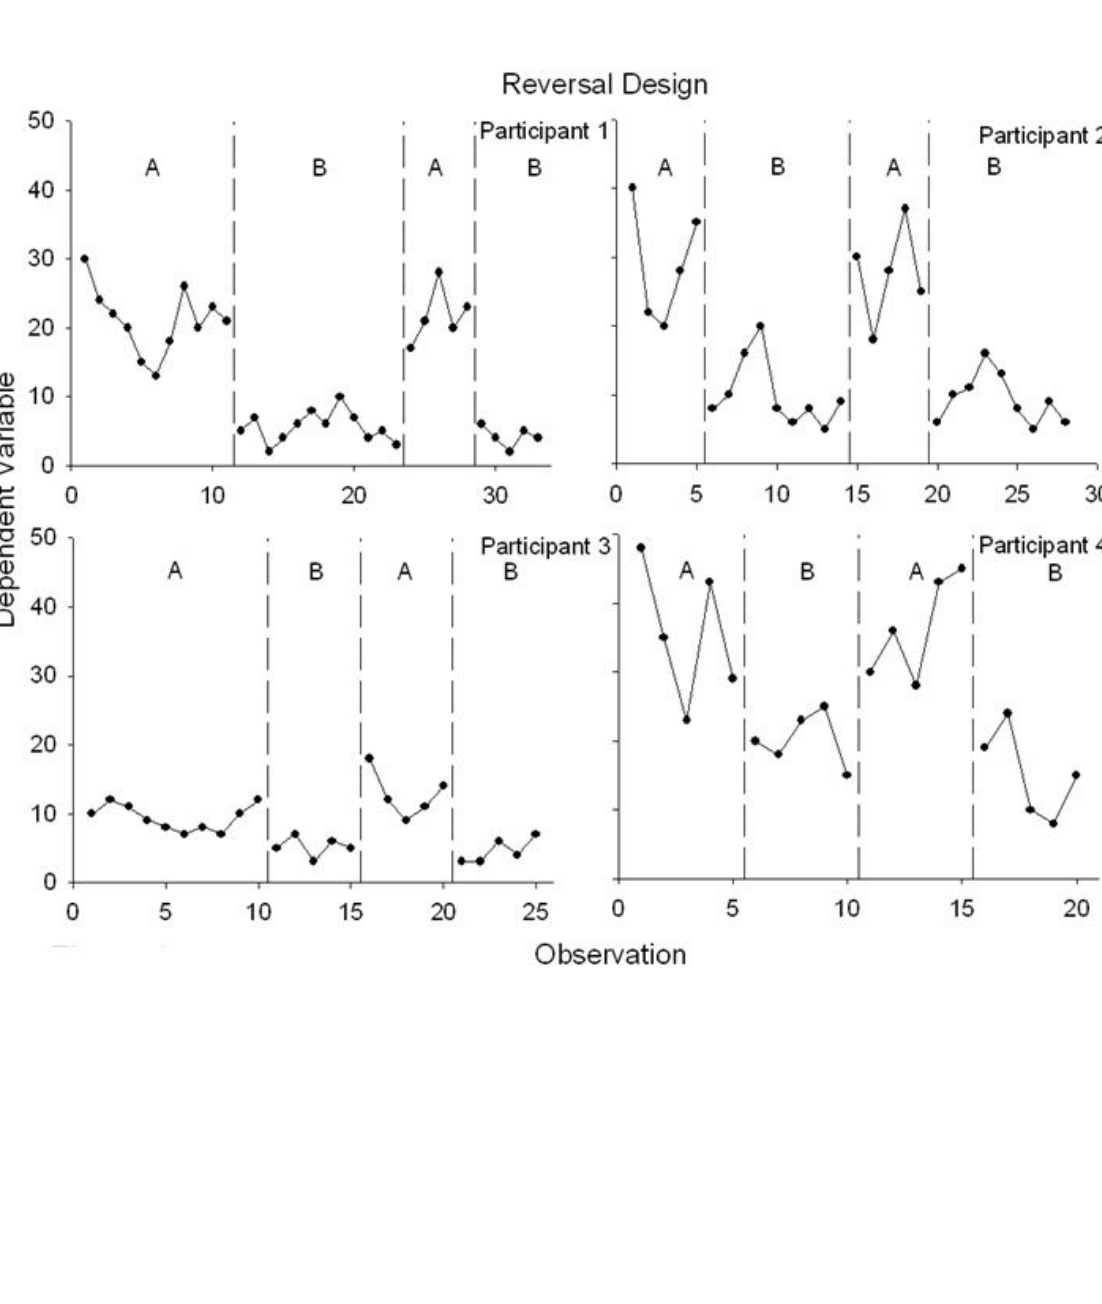
Figure 1. Example of a reversal design showing experimental control and replications within and between subjects (each panel represents a different participant, each of whom experienced two baseline and two treatment